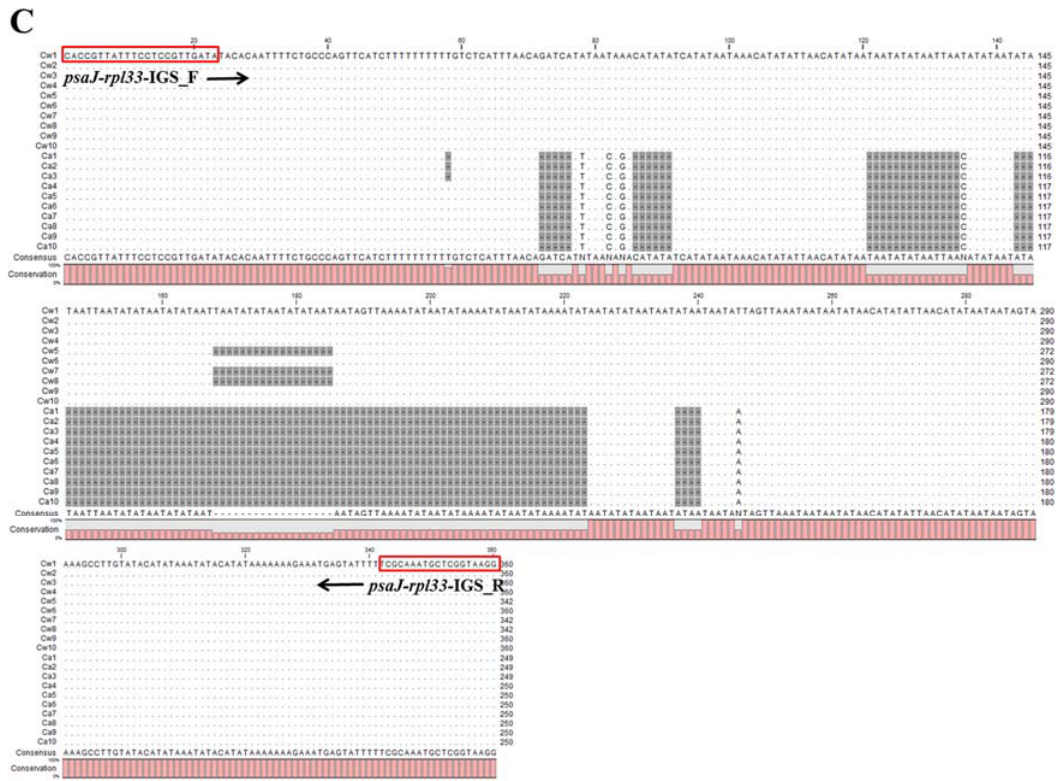
Figure 3. Sequence alignment of the trnQ ‐ psbK ( A ), rps2 ‐ rpoC2 ( B ), and psaJ ‐ rpl33 ( C ) intergenic space regions of C. wilfordii and C. auriculatum samples in this study. Arrows indicate the two designed primer sets ( trnQ ‐ psbK ‐ IGS_F (forward) and R (reverse), rps2 ‐ rpoC2 ‐ IGS_F and R, and psaJ ‐ rpl33 ‐ IGS_F and R); red boxes show the primer sequences.